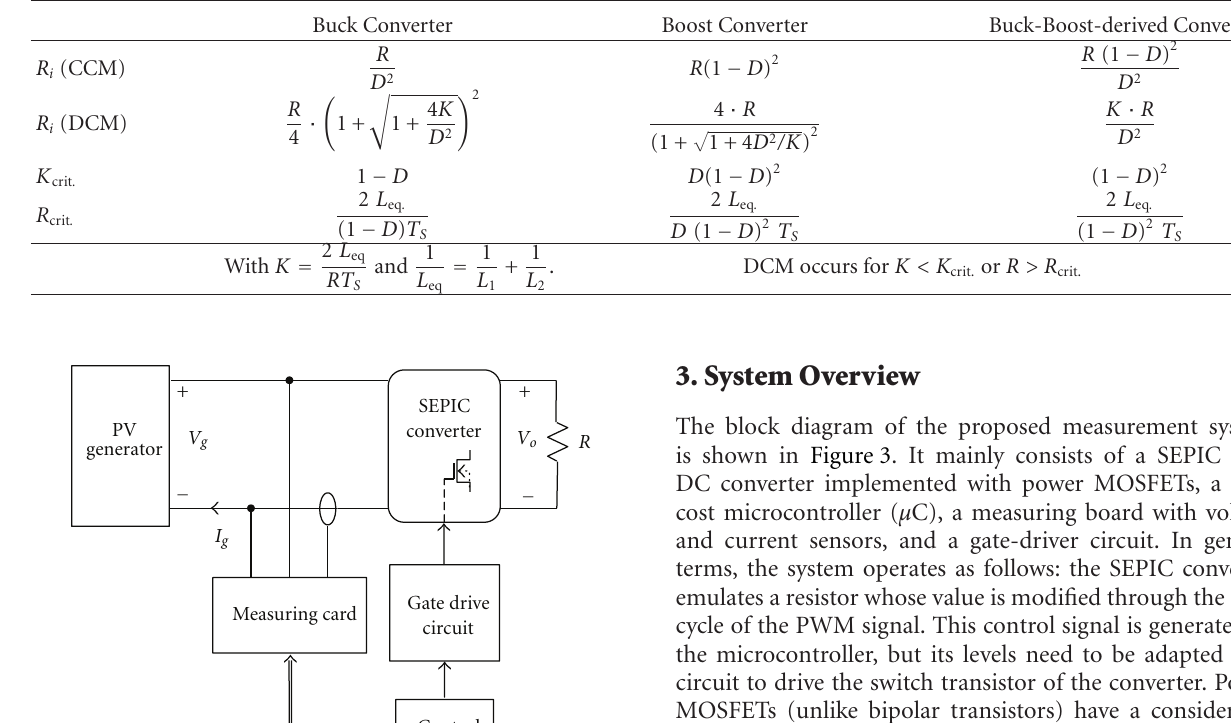
Table 1: Values of R i , R crit . , and K crit. for di ff erent DC-DC converters.